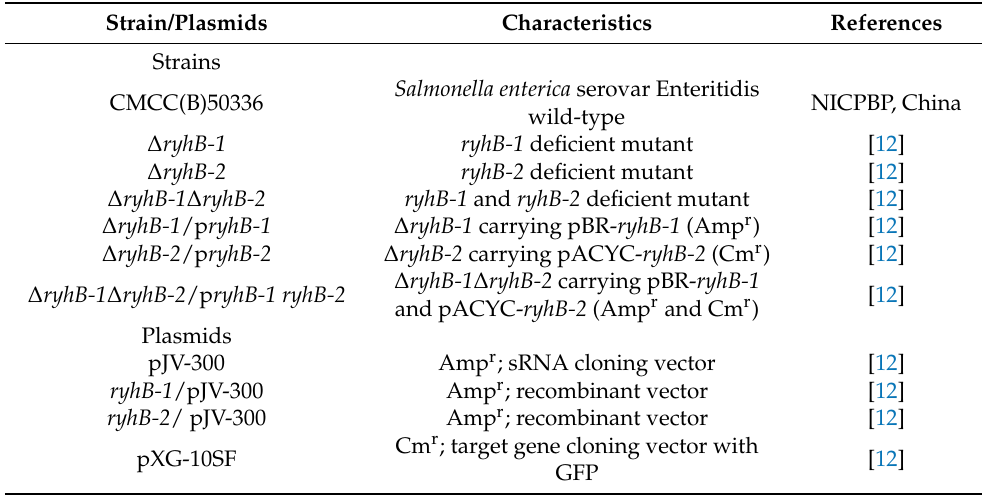
Table 1. Bacteria and plasmids used in this